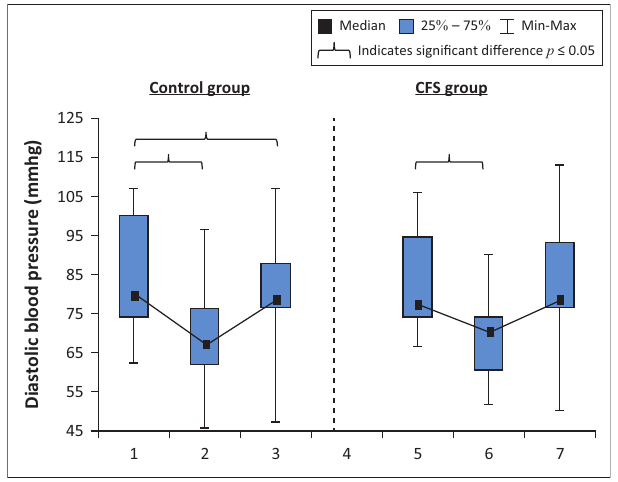
FIGURE 4: Box and whisker plot showing changes in heart rate variability before, during and after immersion for control and chronic fatigue syndrome groups.